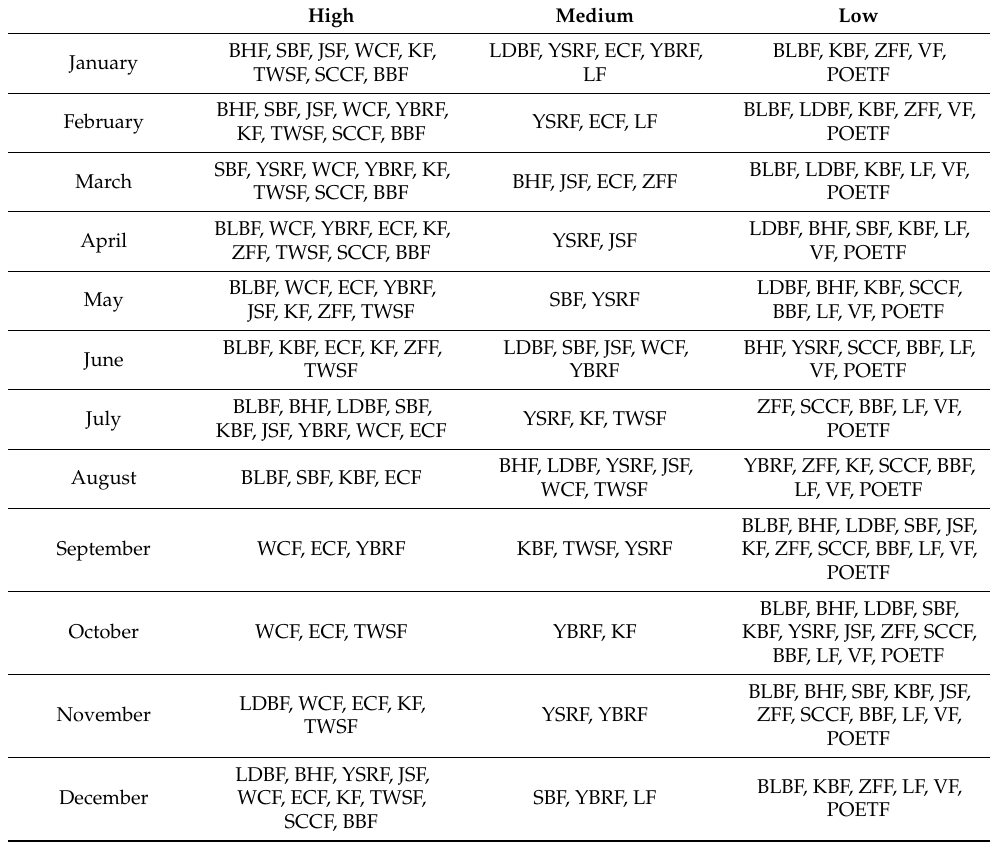
Table 1. Monthly high-, medium-, and low-frequency fronts. High Medium